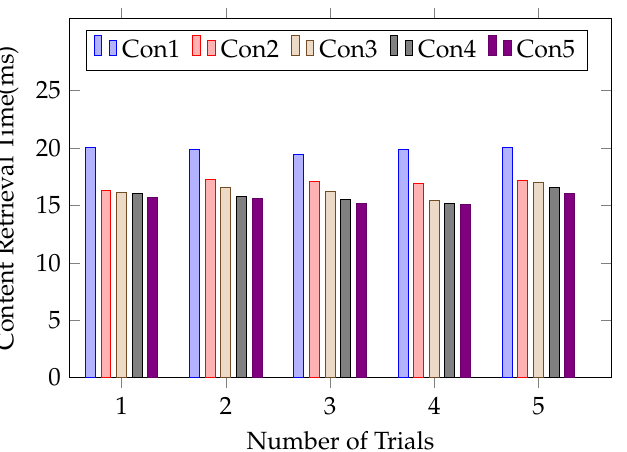
Figure 12. Content retrieval delay for different number of consumers with different identities.